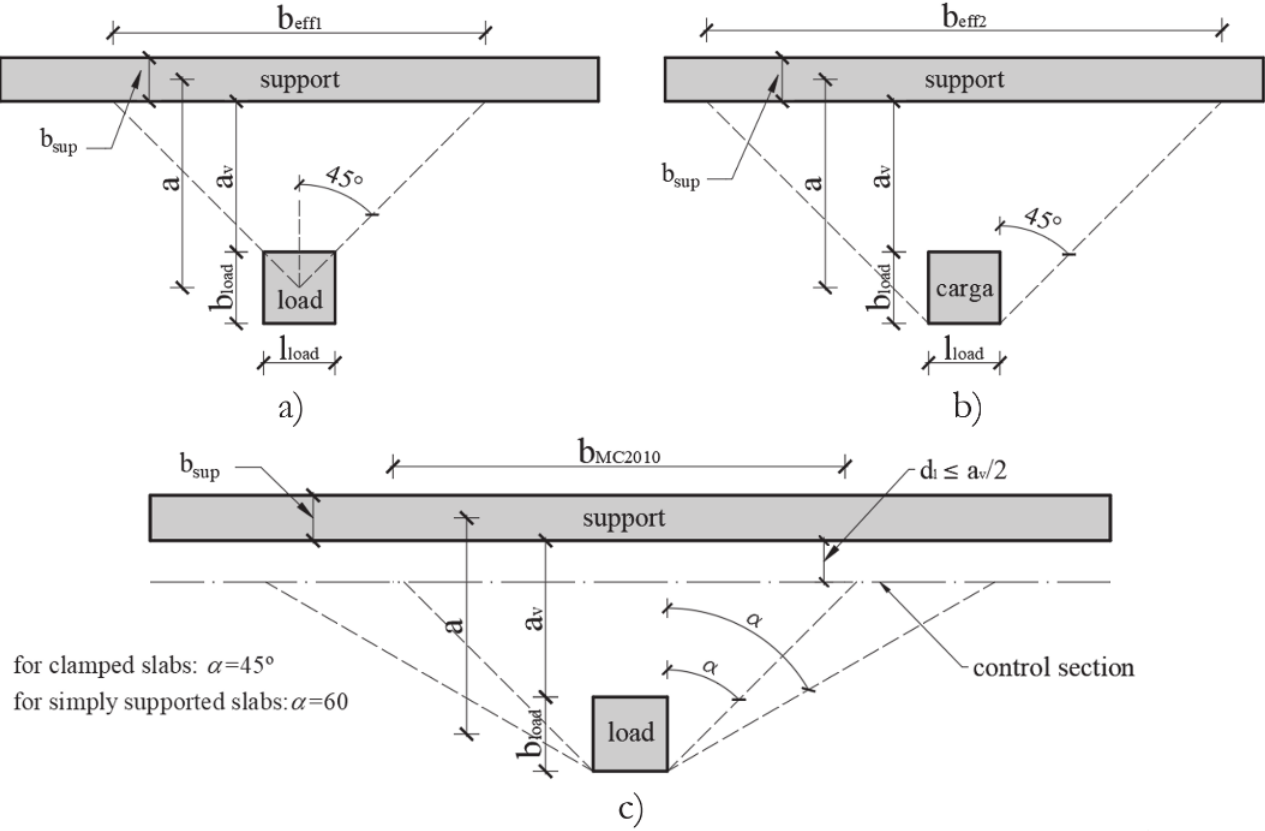
Definition of the effective width in models of one-way shear force strength according